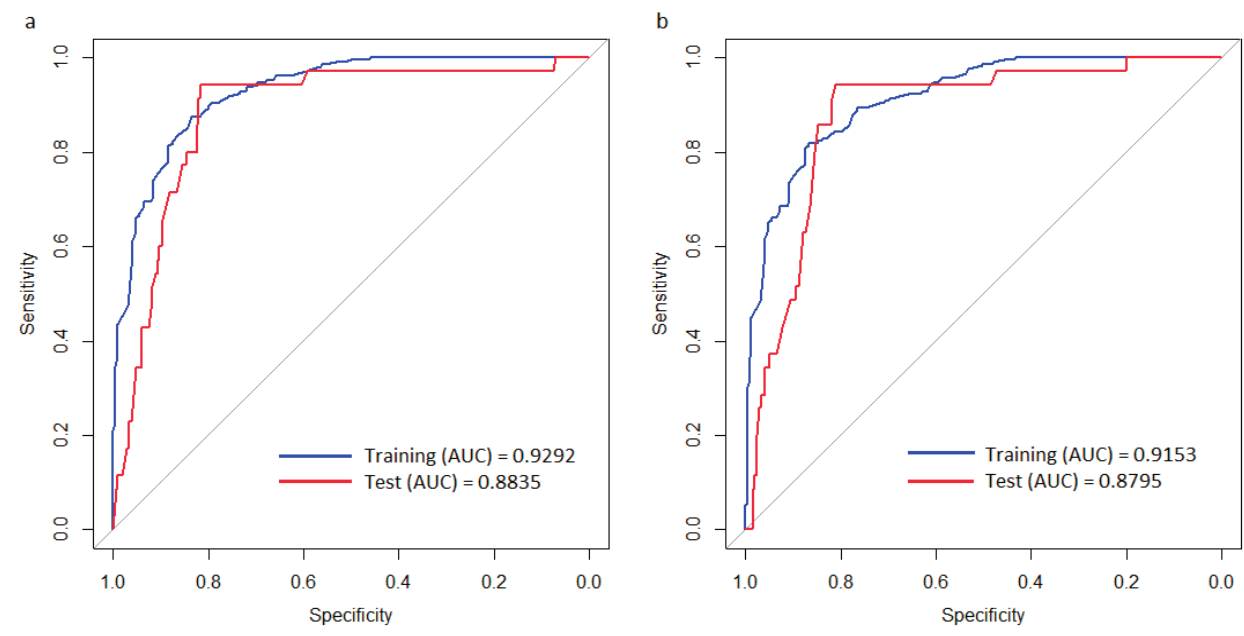
Figure 12. ( a ) Receiver operating characteristic (ROC) curves of the ANFIS and ( b ) ROC curves of the